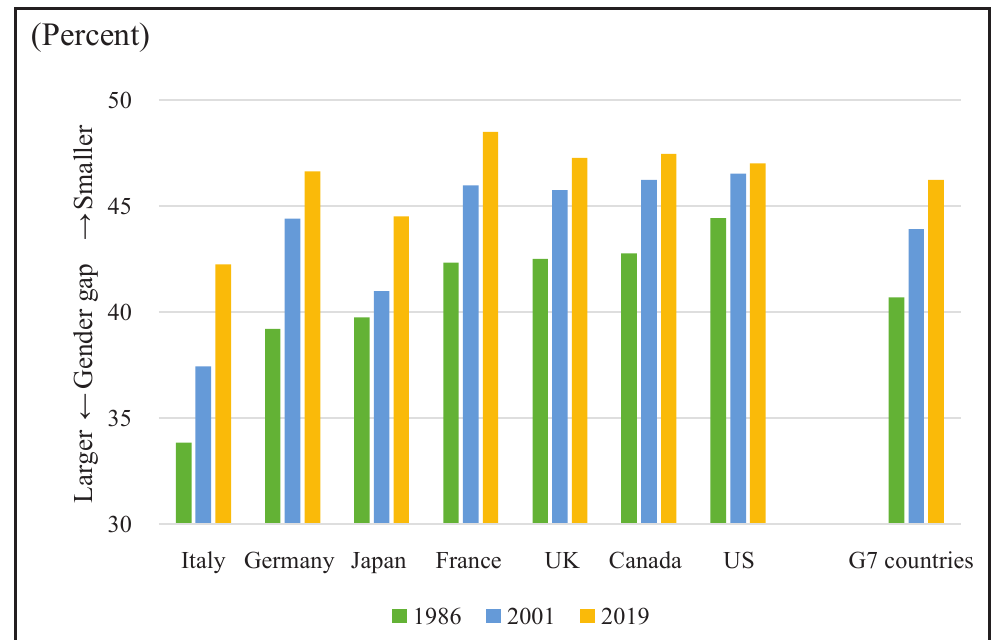
Female share of total employment: 1986–2019.